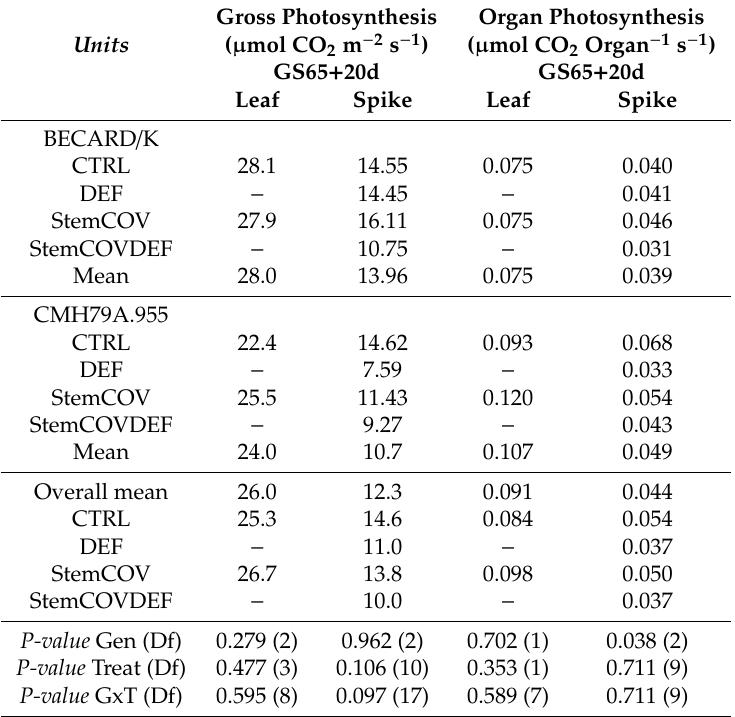
Table 3. Flag-leaf and spike photosynthetic rates per area (gross; µ mol CO 2 m − 2 s − 1 ) and per